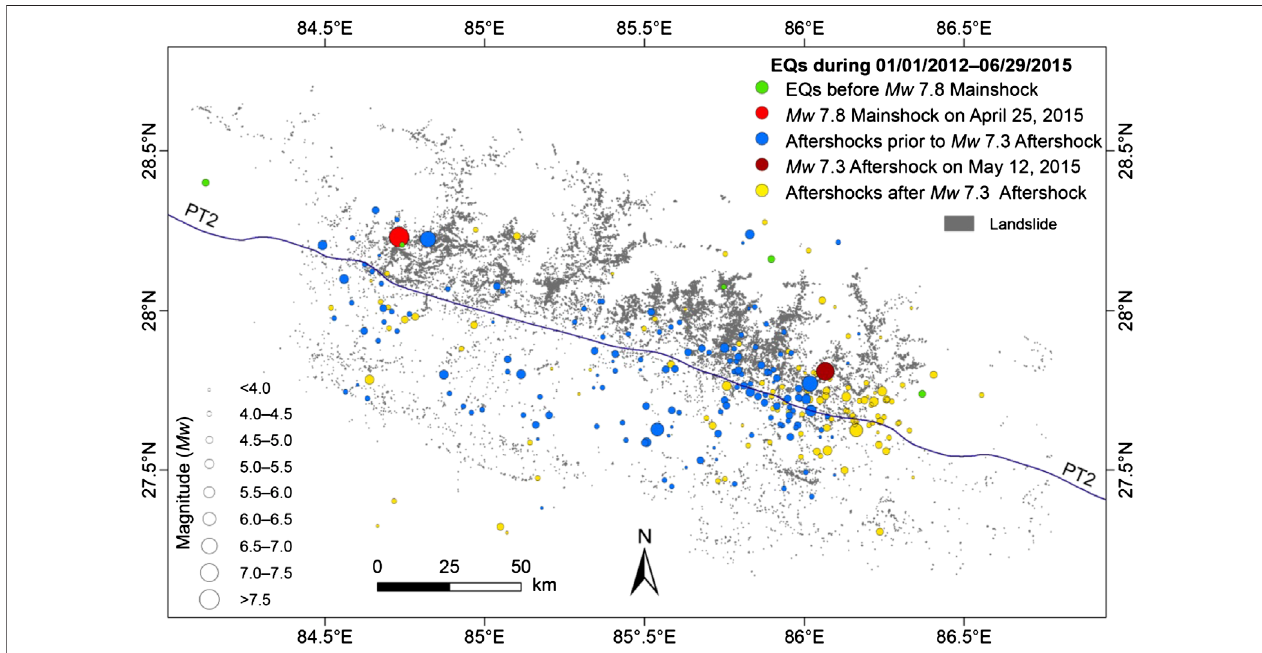
FIGURE9| Earthquake-triggeredlandslidesandsmallmagnitudeearthquakesthatoccurredbeforetheApril25 M w 7.8mainshockaswellastheaftershocksinthe seismic area of the 2015 Gorkha earthquakes. EQ is short for earthquakes. Earthquake data are from USGS (2019). Landslide data are from Xu et al. (2018).